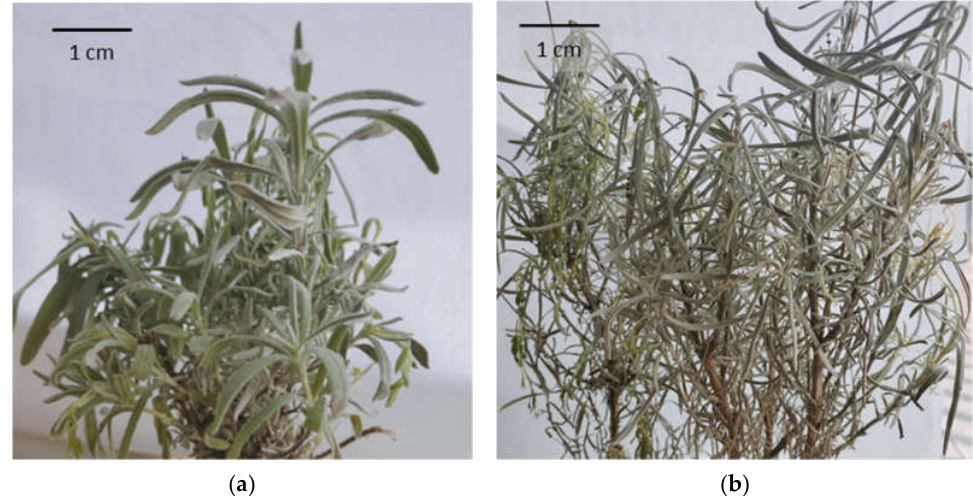
Figure 2. The general appearance of: ( a ) Lavandula angustifolia ‘Munstead’; ( b ) Lavandula × intermedia ‘Grappenhall’. Photos by M.C.-W.